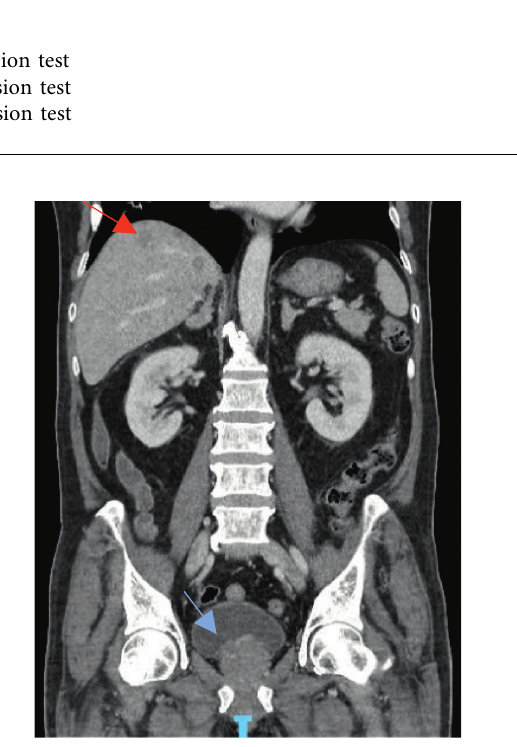
Figure 1: CT thorax abdomen and pelvis showing prostate cancer (blue arrow) with liver metastases (red arrow).